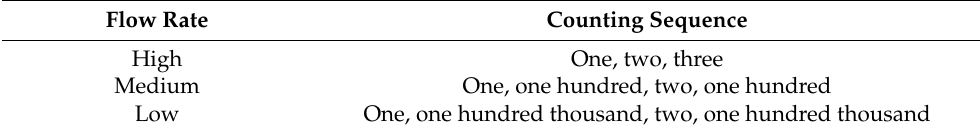
Table 1. Counting sequence for syringe